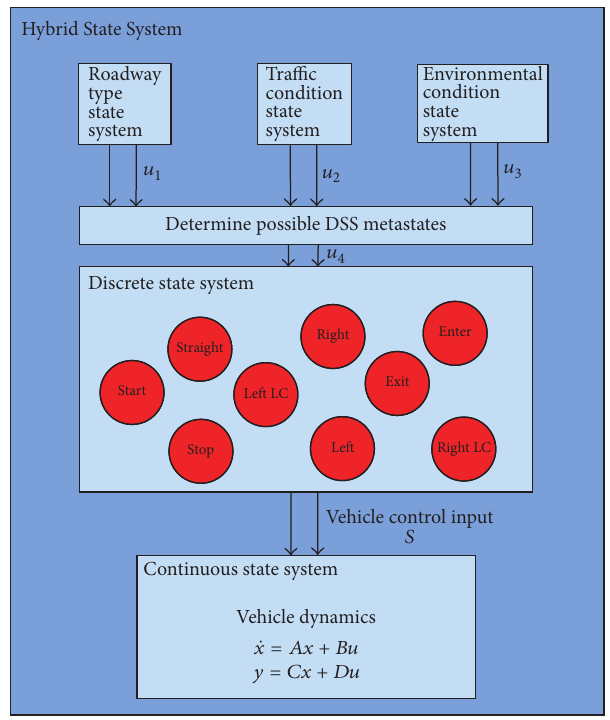
Figure 6: Extended HSS+HMM architecture. Observations mea- sured on a vehicle are the result of driver decisions, road conditions, environmental conditions, and traffic